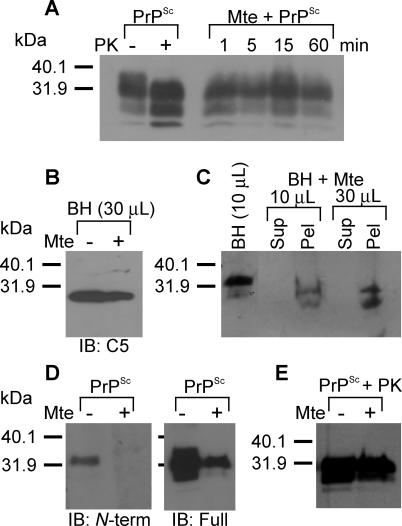
PrPSc Desorbed from Mte Is Cleaved(A) PrPSc cleavage occurs after short contact times with Mte surfaces.(B) The molecular mass protein C2 of the 20S proteasome subunit from BH was unaltered following desorption from Mte.(C) Cleavage of PrPSc present in infected BH was apparent after desorption from Mte.(D) PrPSc desorbed from Mte lost immunoreactivity against an antibody recognizing the N-terminal portion of the mature protein.(E) PrPSc pretreated with PK bound to Mte and did not exhibit further reduction in molecular mass when desorbed.Immunoblots (A, B, and E) used mAb 3F4. Immunoblots (C and D) employed anti-C2 and R20 polyclonal antibodies, respectively. Pel, PrPSc associated with pelleted mineral particles; Sup, unbound PrPSc in supernatant.